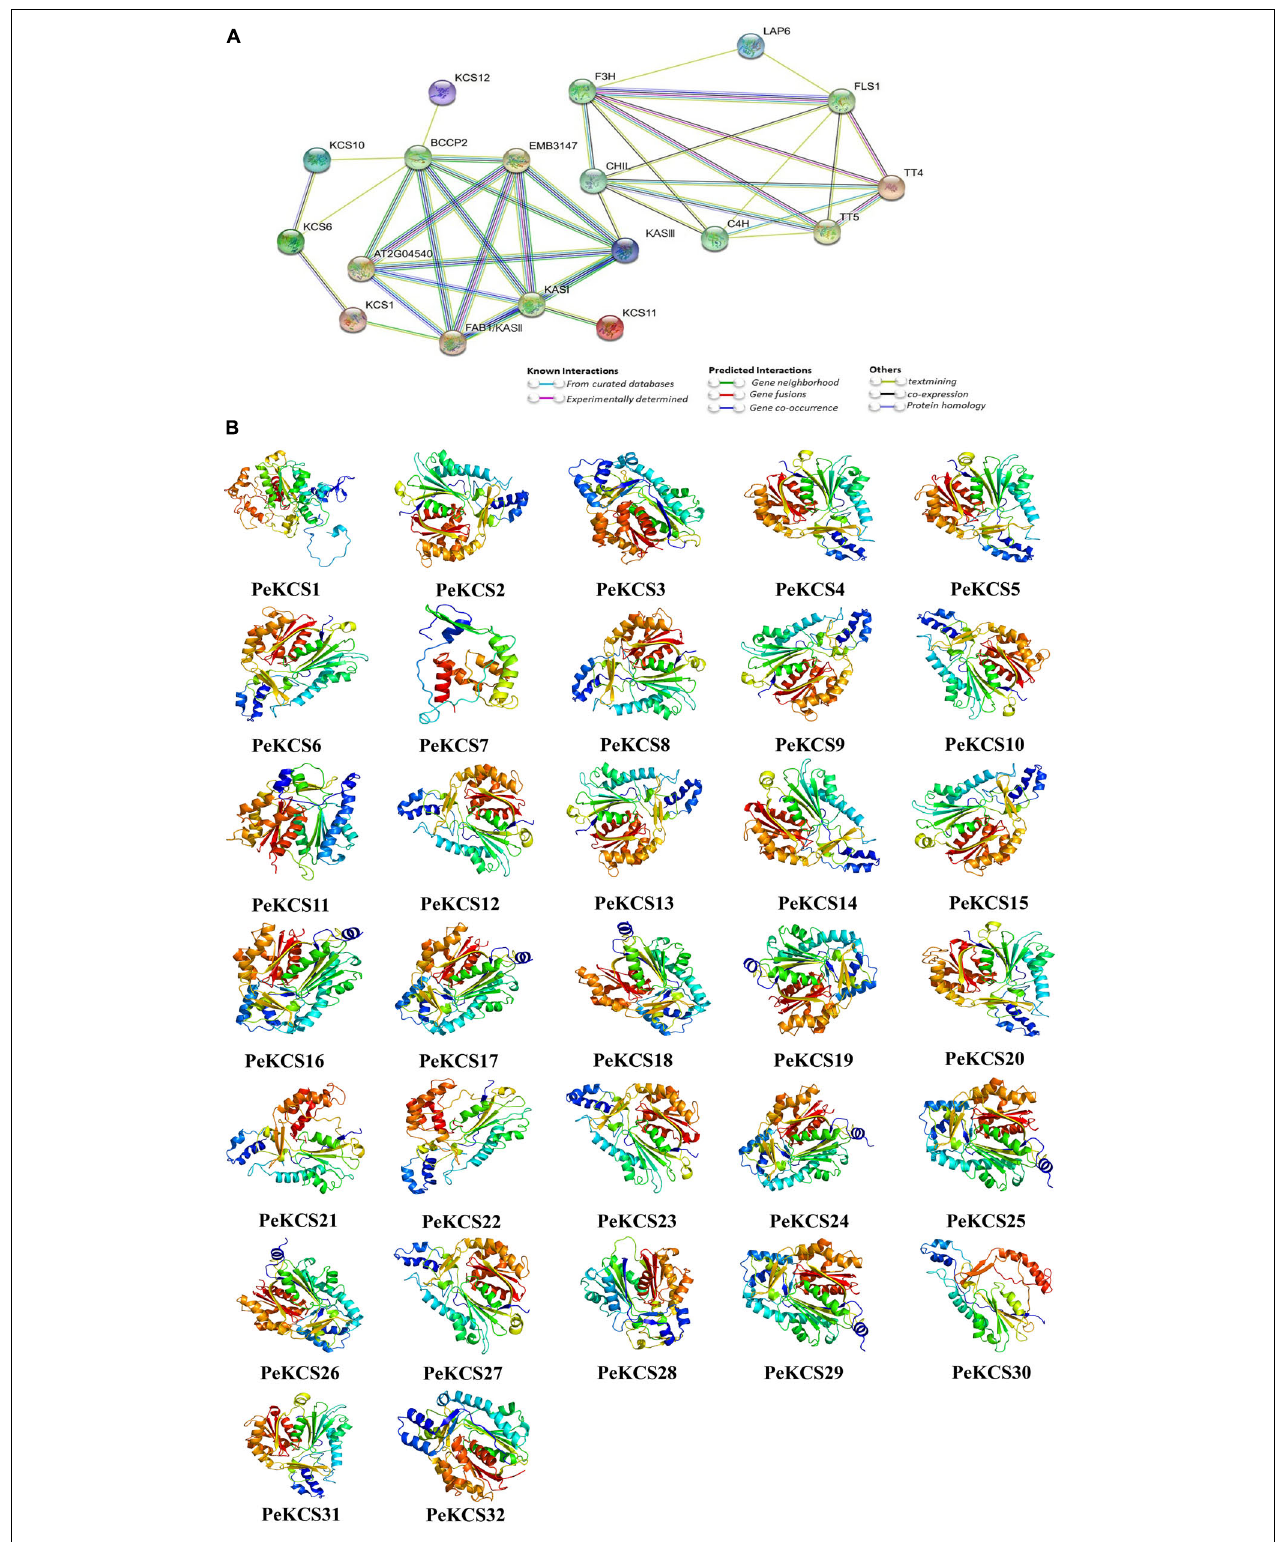
FIGURE 6 | Protein–protein interaction and predicted 3D models of PeKCS proteins. (A) The network was constructed using online STRING software. The proteins are displayed at network nodes with 3D structure of the proteins within nodes and the lines colors indicate different data sources. The higher the interaction coefficient, the thicker the network lines between proteins and vice versa. (B) 3D models were constructed using the online Phyre2 server with default mode.